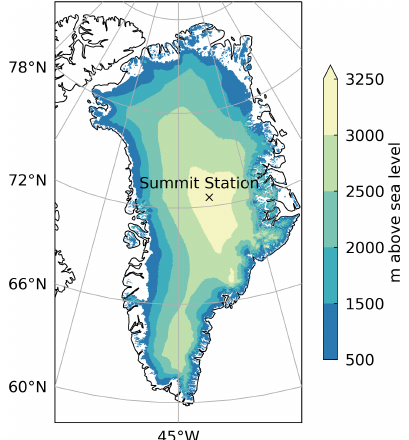
Figure 1. Location of Summit Station at the highest point on the Greenland Ice Sheet. Ice elevation contours are from the Greenland Ice Mapping Project (Howat et al.,